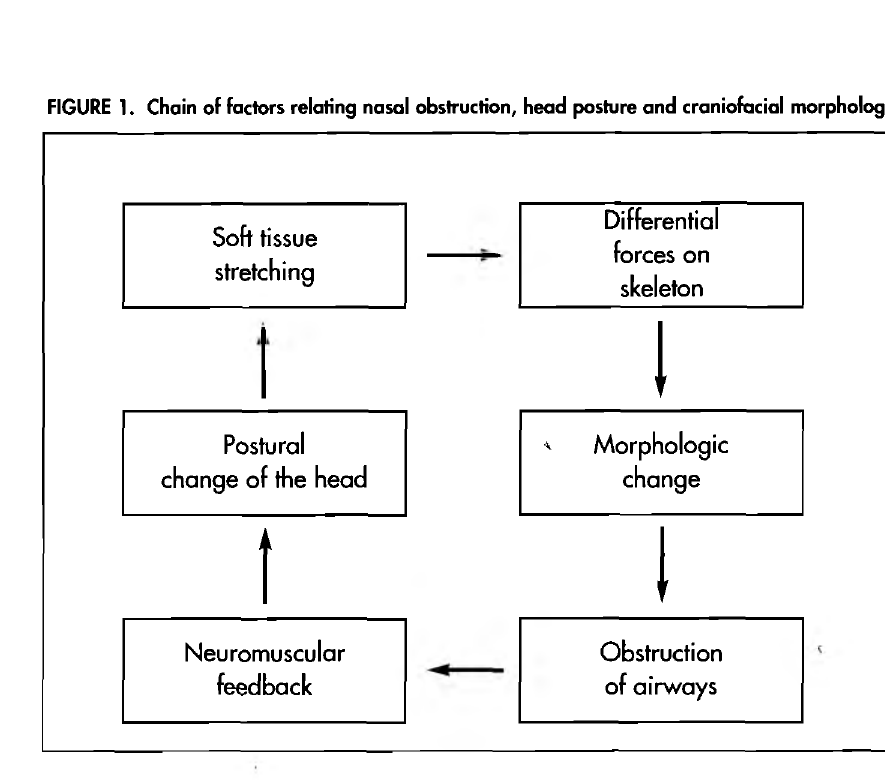
FIGURE 1. Chain of factors relating nasal obstruction, head posture and craniofacial morphology